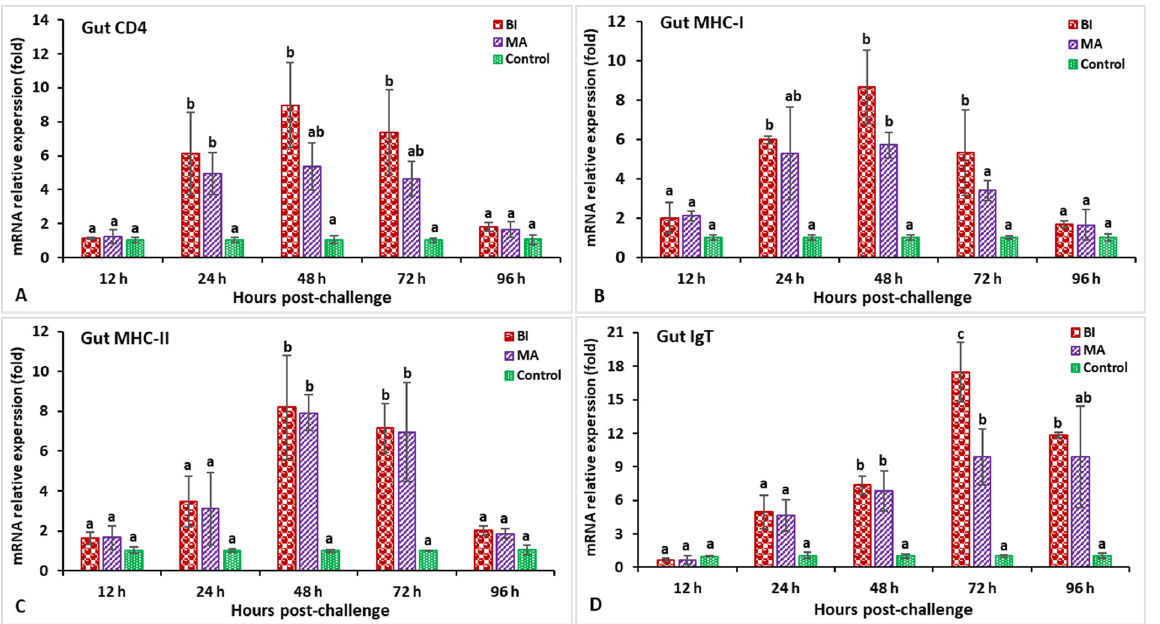
Figure 14. The gene expression of CD4 ( A ), MHC-I ( B ), MHC-II ( C ), and IgT ( D ) in the hindgut tissue of orally vaccinated fish after being challenged by Aeromonas hydrophila (mean ± SE, n = 3). Dissimilar letters denote significant differences ( p < 0.05).